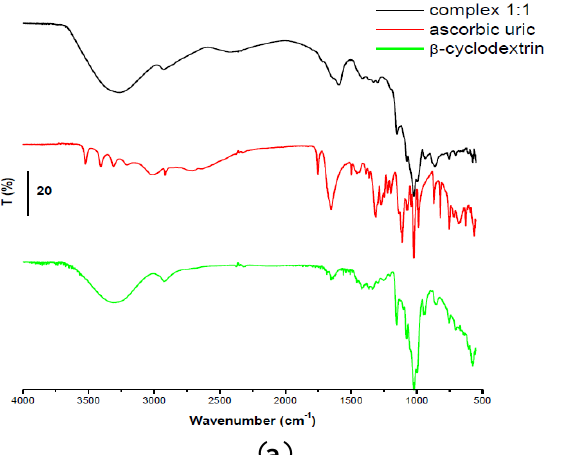
Figure 3. FTIR spectra of β-CD, AA ( a ); UA ( b ) and inclusion